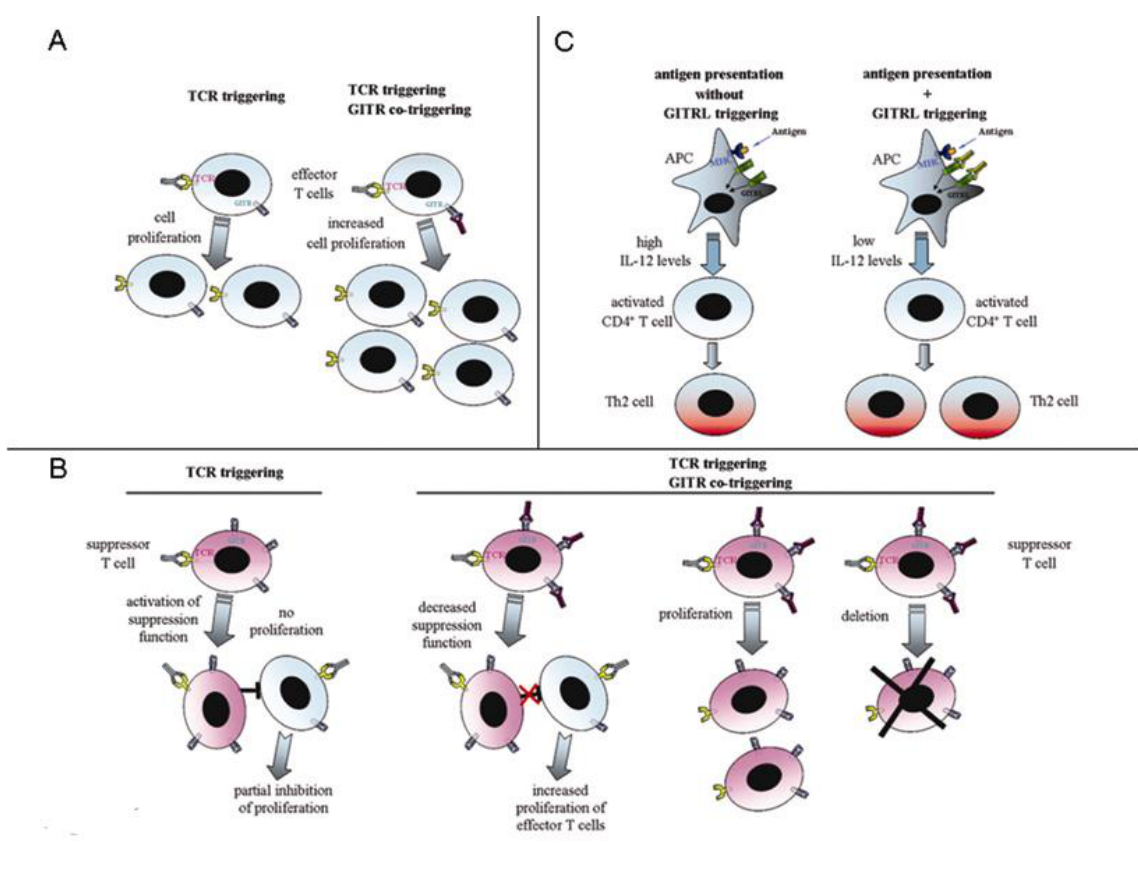
FIGURE 3. Role of GITR/GITRL system in modulation of T cell activation Panel A, co-stimulatory role of GITR; panel B, effect of GITR co-triggering on suppressor T cells (Treg); panel C, switch to Th2 differentiation modulated by GITRL triggering on APC. GITR in T Cell Regulation: Co-activating Function on Effector T